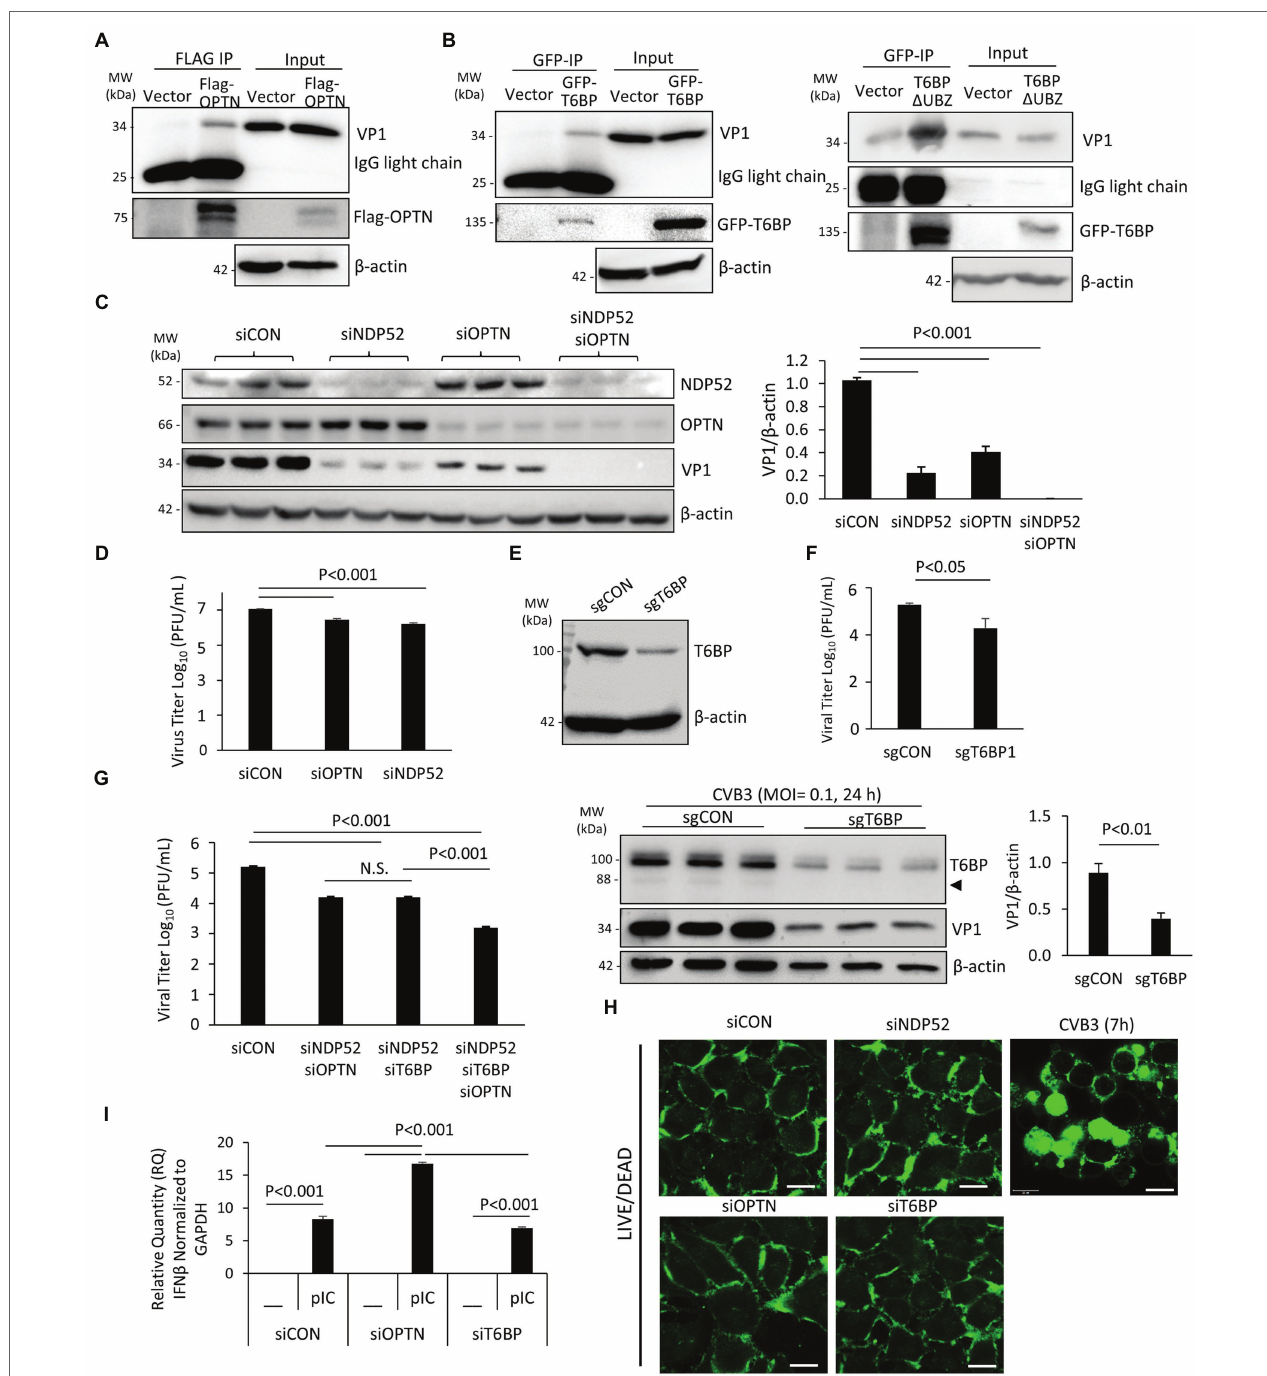
FIGURE 5 | T6BP and OPTN regulate CVB3 infectivity. ( A and B ) HeLa cells were transfected with either 3× Flag-OPTN (A) , GFP-T6BP (B, left), or GFP-T6BP- Δ UBZ (B, right) for 24 h prior to CVB3 infection (MOI = 10) for additional 5 h. Cell lysates were subjected to immunoprecipitation with anti-Flag (A) or anti-GFP (B) antibodies, respectively, and analyzed by Western blotting. (C) HeLa cells were transiently transfected with small interfering RNA (siRNAs) targeting NDP52 (siNDP52) or/and OPTN (siOPTN), or a scramble siRNA control (siCON) as indicated for 48 h, followed by CVB3 infection (MOI = 0.1) for 24 h. Western blotting was performed to examine the protein expression of NDP52, OPTN, VP1, and β -actin. Protein levels of VP1 were quantified by densitometric analysis and presented in the bar graph (mean ± SD, n = 3). (D) HeLa cells were treated as above. Cell-associated virus titers were determined by TCID50 assay. Data are represented as mean ± SD from three replicates. (E) HeLa cells were transfected with constructs expressing sgRNA targeting T6BP (sgT6BP) or scramble control (sgCON) for 48 h. Knockdown efficiency was verified by Western blotting with anti-T6BP antibody. (F) HeLa cells were treated as above (E) and infected with CVB3 (MOI = 0.1) for 24 h. Cell-associated virus titers were determined by TCID50 assay. Data are representative of mean ± SD from three replicates. Corresponding lysates from